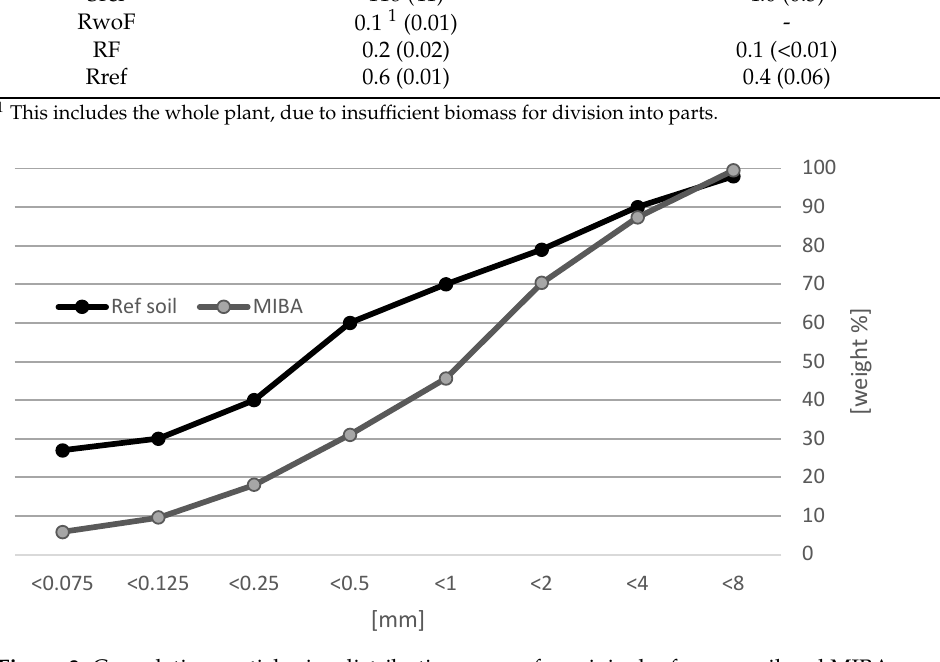
Figure 3. Cumulative particle size distribution curves for original reference soil and MIBA.